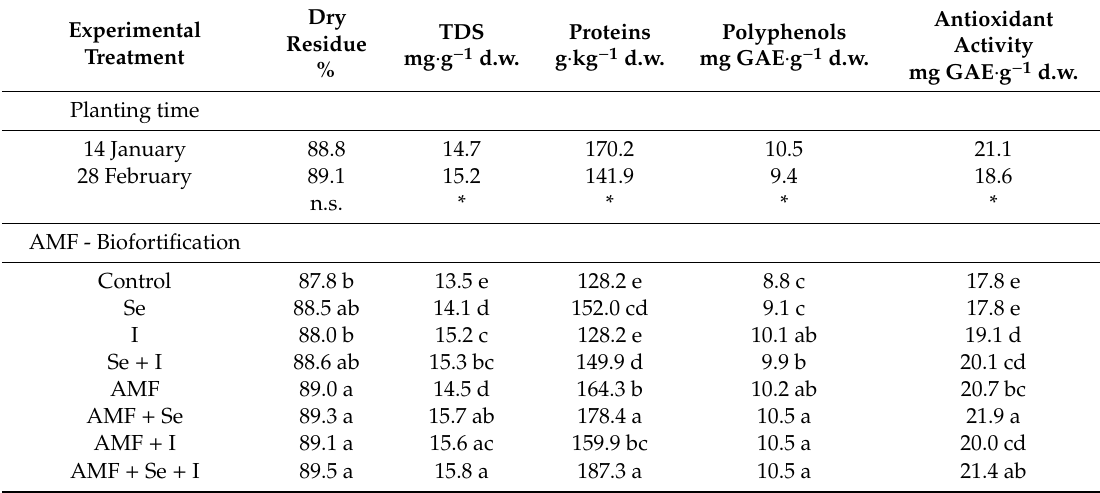
Quality indicators and antioxidants of chickpea seeds as a ff ected by planting time, AMF inoculation, and Se and I